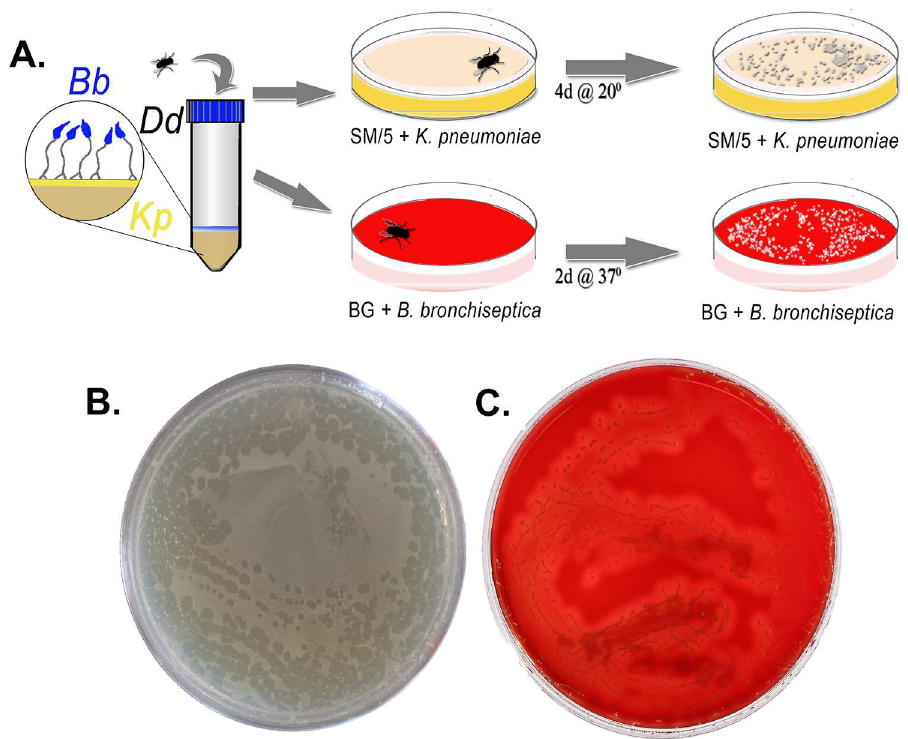
Fig 9. B . bronchiseptica in amoeba sori can be transmitted via an intermediary to a new geographical location. ( A) Schematic showingthe experimental setup in which flies were added to conicaltubes containing B . bronchiseptica– filled fruiting bodies. Flies were then transferred to new plates containing either a lawn of K . pneumoniae (yellowplates, top) to assess amoebatransmissionor Bordet-Gengou (BG) agar with streptomycin (red plates, bottom) to assess Bordetella transmission.(B) Representative image showing amoebaplaquegrowth along the fly’s footprints. (C) Representative image showing B . bronchiseptica colony growth along the fly’s footprints. Bb , B . bronchiseptica ; Dd , D . discoideum ; Kp , K . pneumoniae